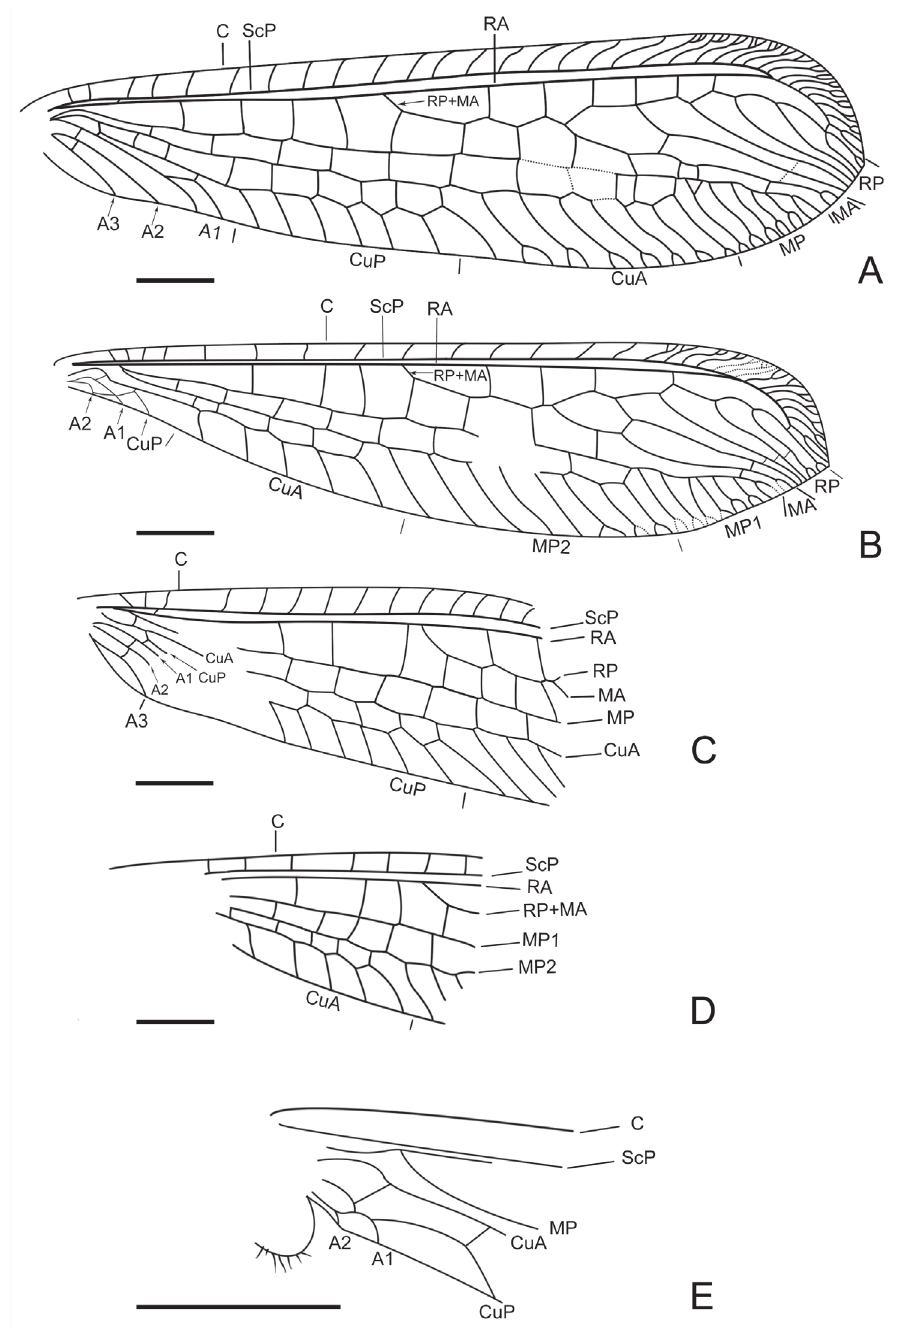
Figure 3. Wing venation of Parababinskaia makarkini sp. n., male. A Line drawing of right forewing B Line drawing of right hind wing C Line drawing of left forewing D Line drawing of left hind wing E Basal part of left hind wing. Scale bars: 1.0